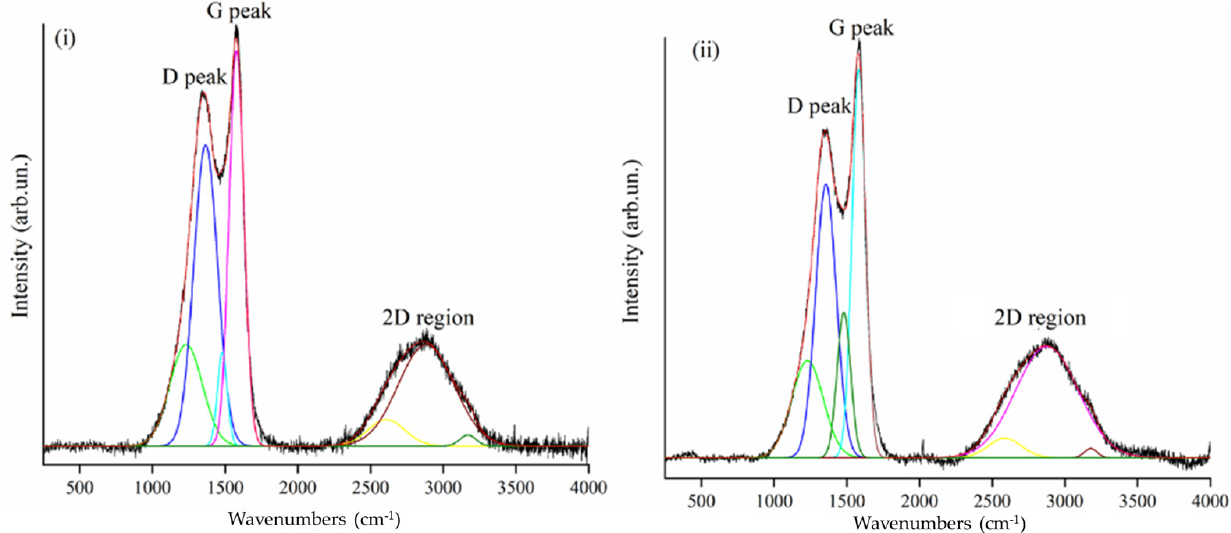
Figure 5. Raman spectra in the range from 500 cm − 1 up to 4000 cm − 1 of ( i ) CNF_230 and ( ii ) CNF_260. Both Raman spectra of CNF_230 and CNF_260 show sharp D and G peaks and